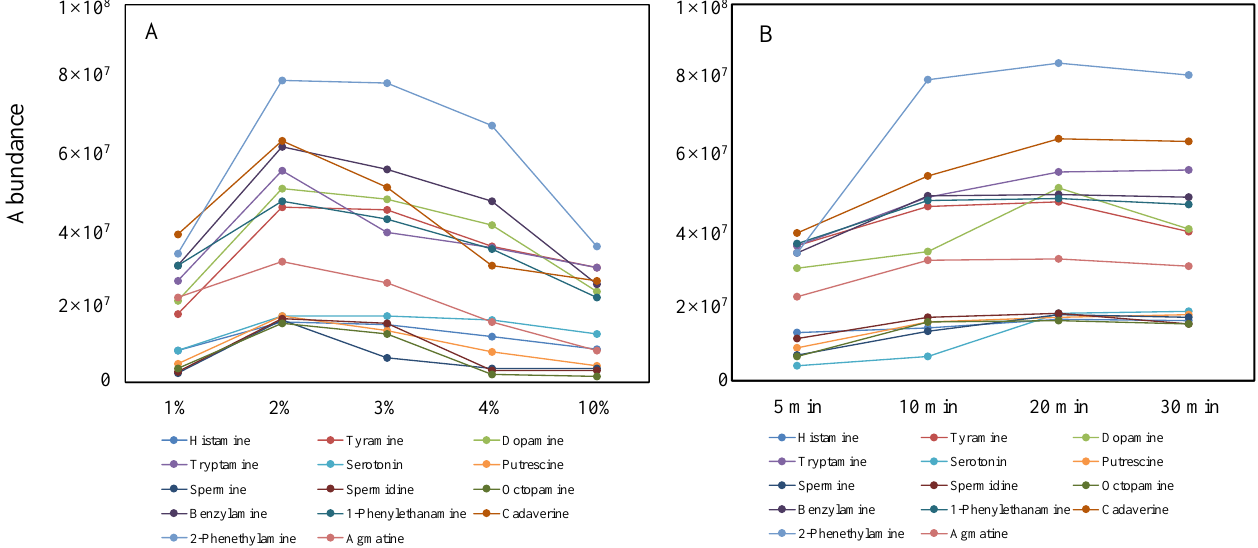
Figure 3. Optimization of the concentration of benzoyl chloride ( A ) and vortex time ( B ).